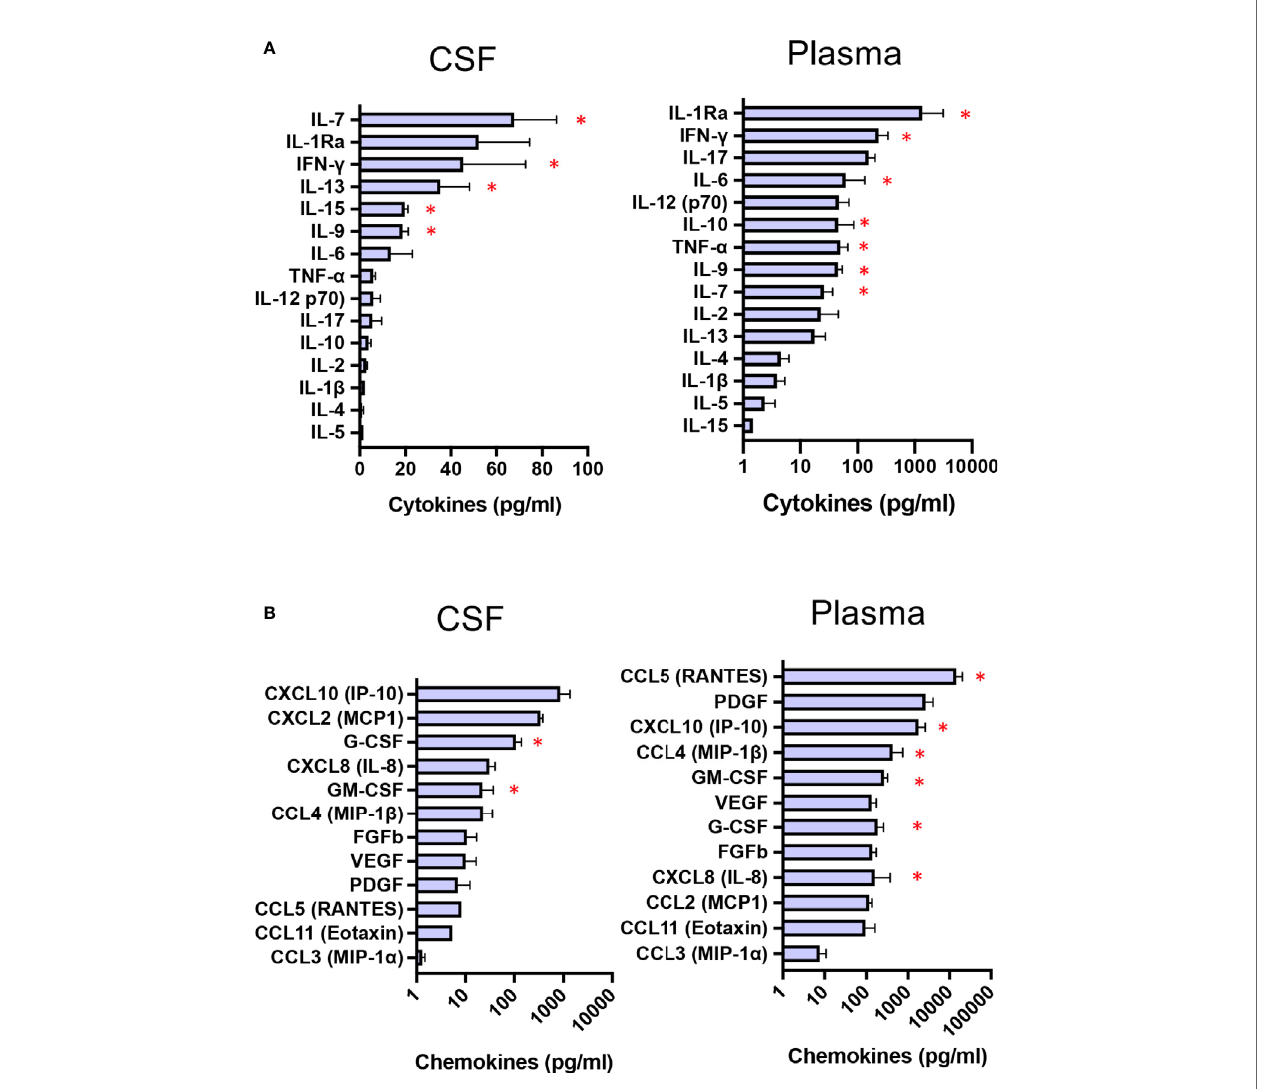
FIGURE 6 | Baseline CSF and plasma cytokine/chemokine pro fi les. Boxplot diagrams of cytokine (A) and chemokine (B) concentrations in CSF and plasma from the four patients at baseline, assessed by multianalyte pro fi ling of 27 cytokines and chemokines. Red star highlights cytokines or chemokines for which the values are markedly higher than those for healthy children (29). Data are presented as mean ± SD of cytokine/chemokine